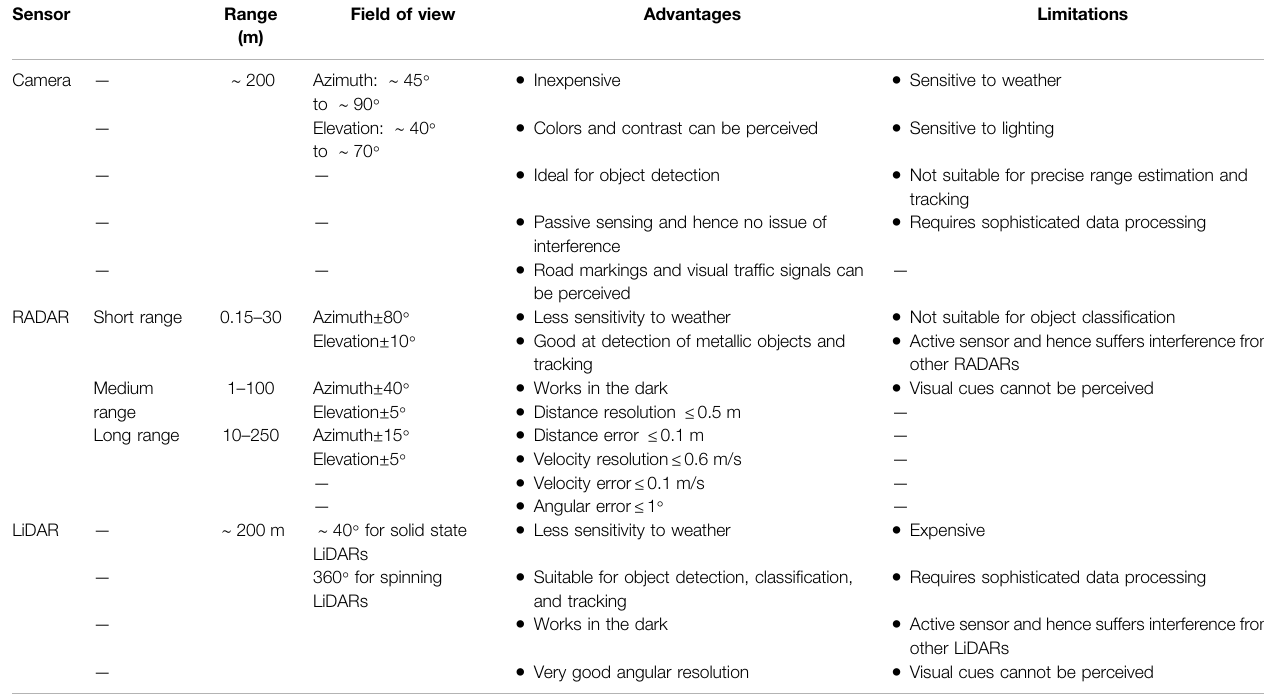
TABLE 1 | Comparison of sensors used for environment perception. Sensor Range